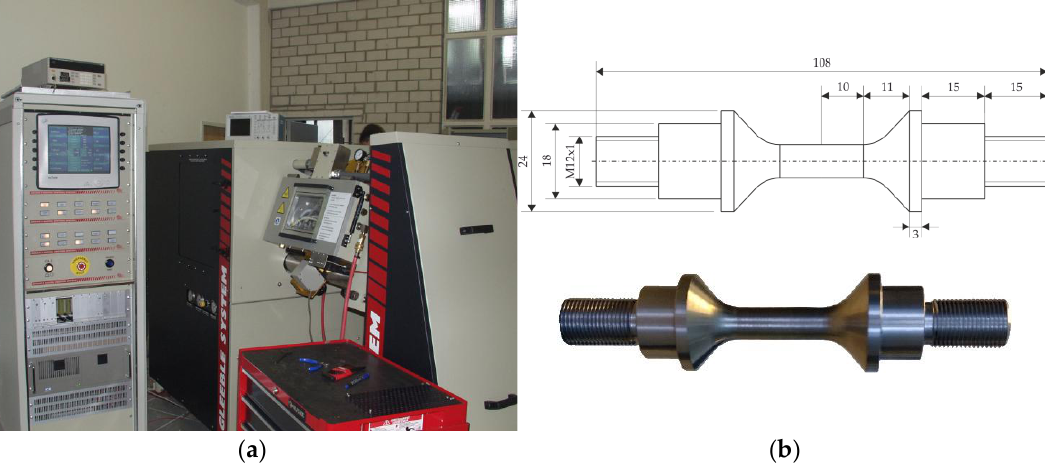
Figure 6. ( a ) DSI Gleeble 3500 servo-hydraulic deformation dilatometer used for the strain-controlled cyclic tests at different temperature levels. ( b ) Low cycle fatigue specimen. Table 2. Determined Chaboche parameters for 42CrMo4 + QT (47 HRC) / AISI 4140.